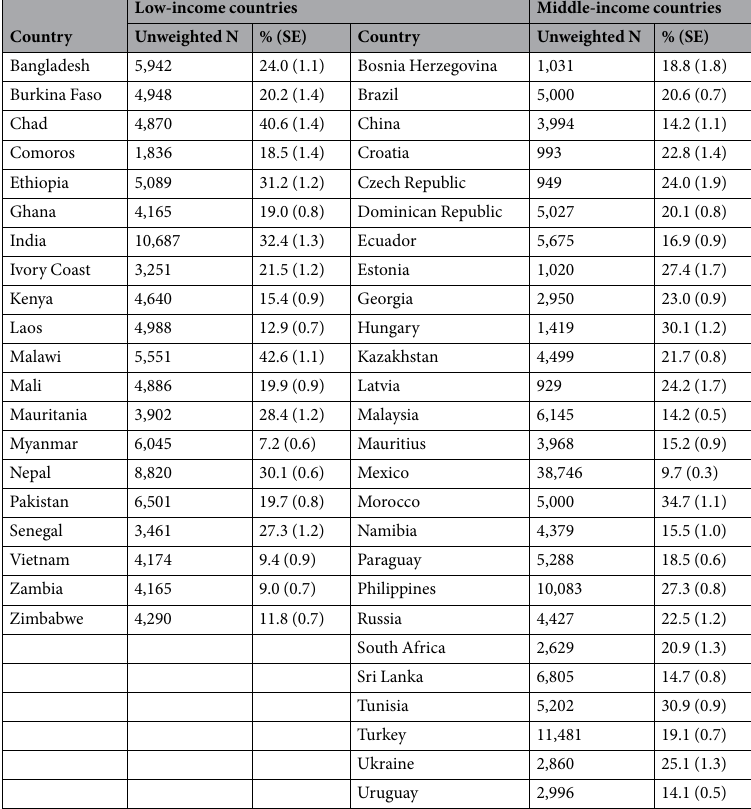
Table 1. Sample size and age- and sex-adjusted prevalence of arthritis by country. Abbreviation: SE standard error. All age- and sex-adjusted weighted estimates were calculated using the United Nations population pyramids for the year 2010.